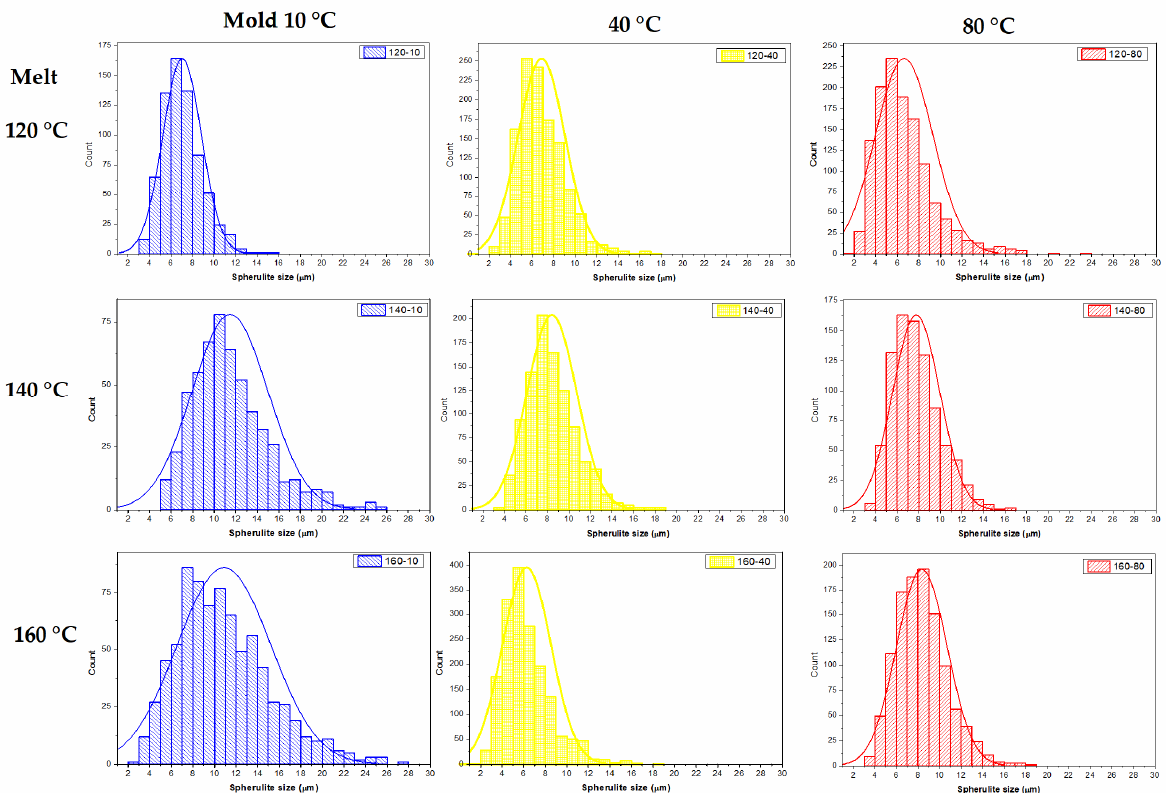
Figure 2. Histogram for the spherulite size distribution of LDPE injection-molded specimens. Table 2. Summary of the spherulite size and crystallinity measurements of LDPE injection-molded specimens. Injection Molding Condition